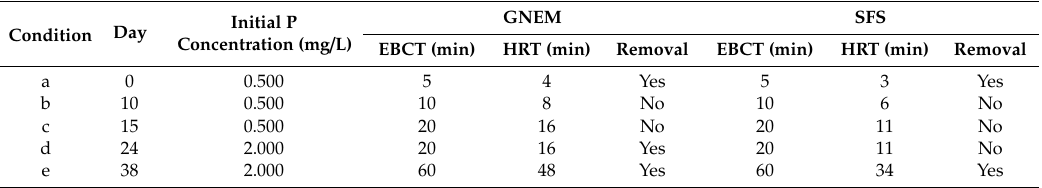
Table 6. Additional column experimentation and respective conditions.